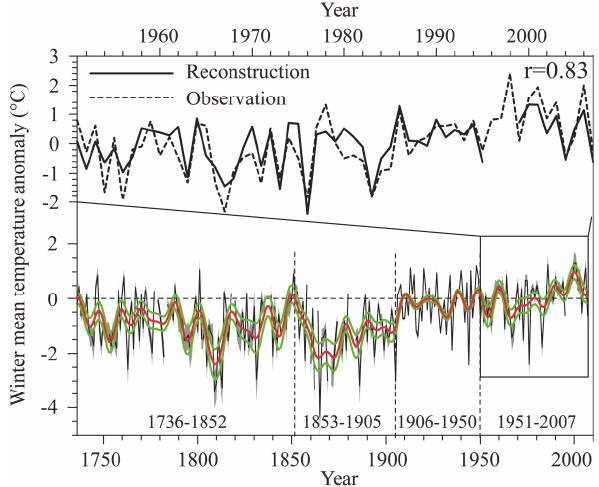
Fig. 2. Mean winter temperature anomalies from 1736 to 2007, with the 95% confidence interval and a comparison between reconstruc- tion and observation data from 1951 to 2007. Red line indicates the 10-yr Fast Fourier Transform low-pass filter, and the green lines are the 10-yr Fast Fourier Transform low-pass filters for the 95% con- fidence intervals; base period: 1951–2007.